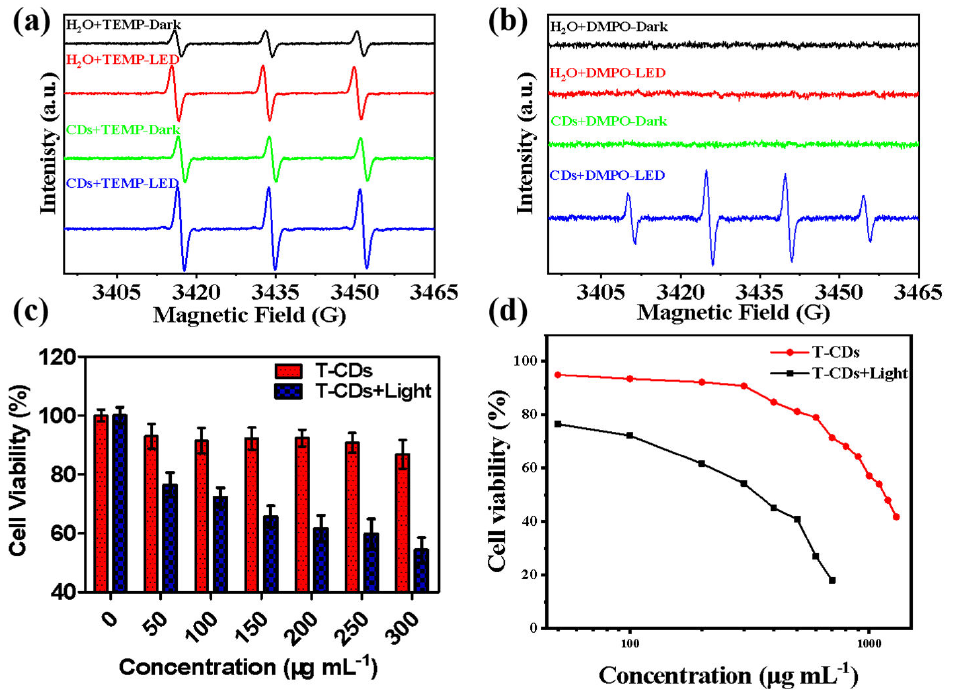
Figure 4. EPR spectra of H 2 O and T − CDs under LED irradiation, ( a ) TEMP as 1 O 2 trapper and ( b ) DMPO as ·OH trapper. Samples are irradiated by LED (400–500 nm, 15 mW cm −2 ) for 12 min. ( c ) MTT results of the 4T1 cells treated with T − CDs in the dark and under LED light irradiation (12 min), ( d ) The half maximal inhibitory concentration (IC50) values for T − CDs with or without light against 4T1 cell lines by MTT assay.